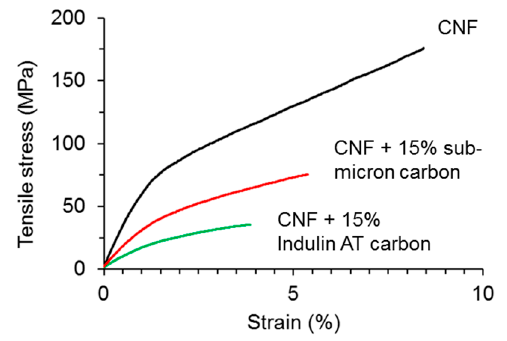
Figure 4. Representative stress-strain curves from tensile tests with pure cellulose nanopaper (CNF) and nanopaper filled with 15 wt.% carbon particles.